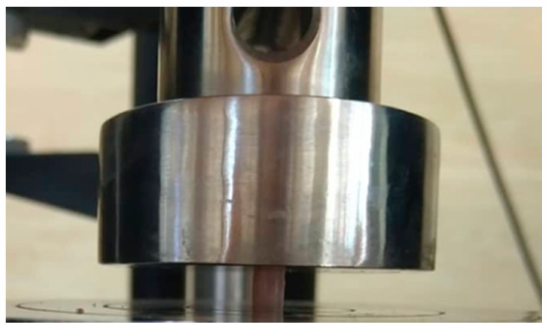
Figure 2. Experimental set up for compressive strength